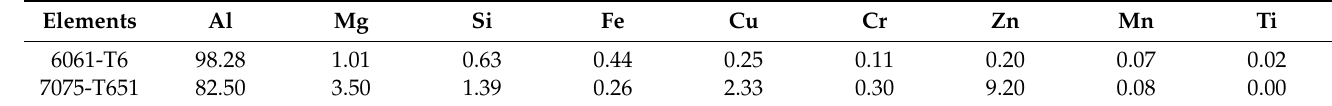
Table 1. The chemical composition of AA6061-T6 and AA7075-T651 aluminum alloys.